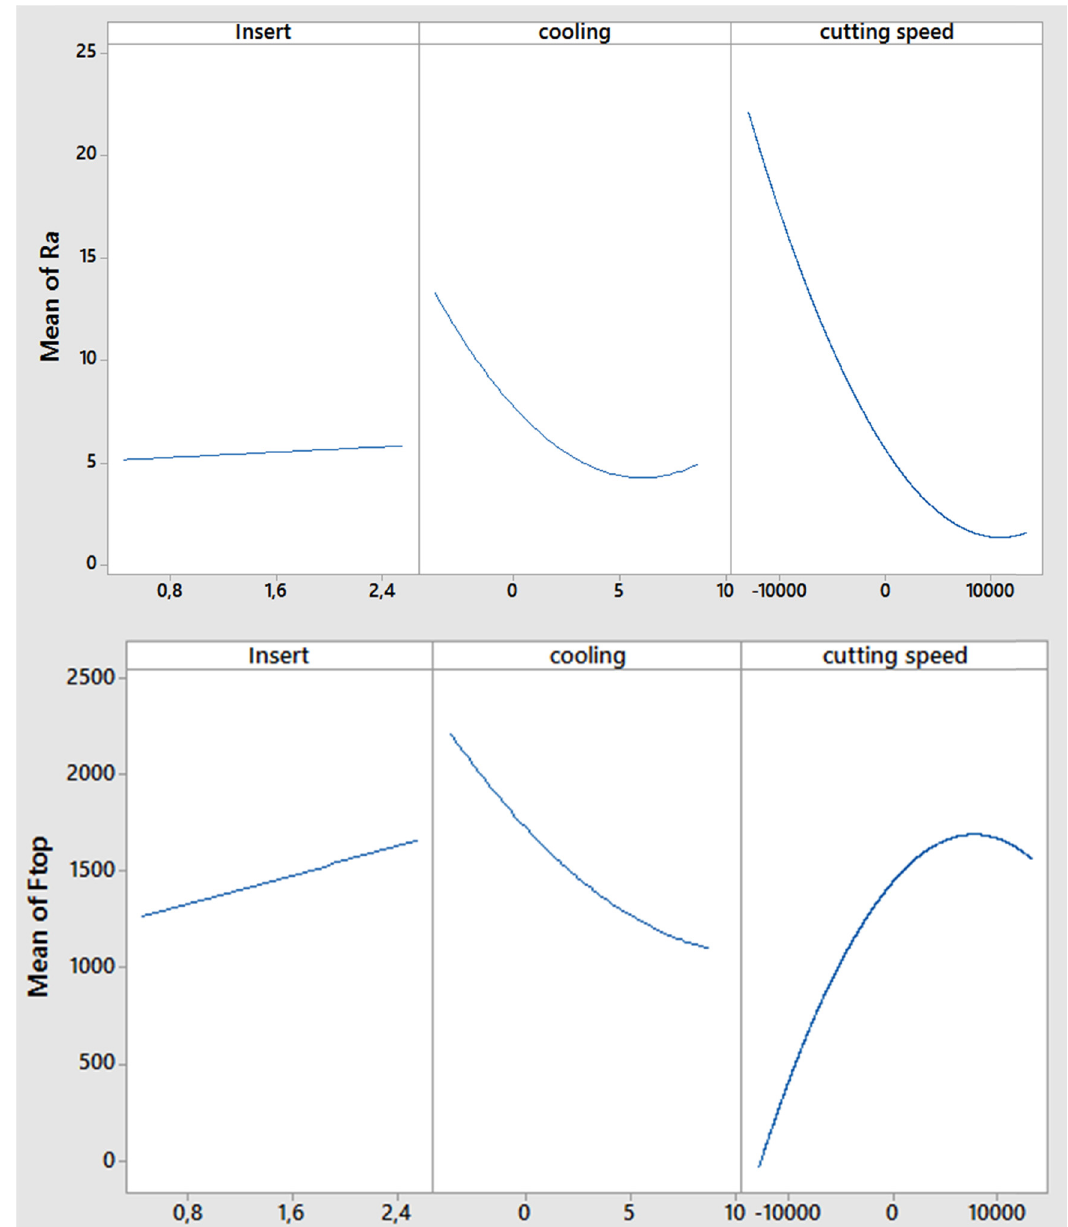
Figure 5: E ff ect of machinability parameters on F top and R a